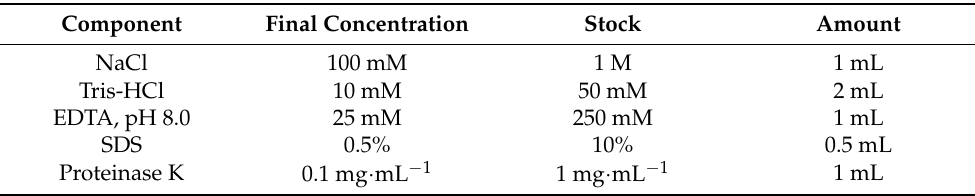
Table 1. Composition of